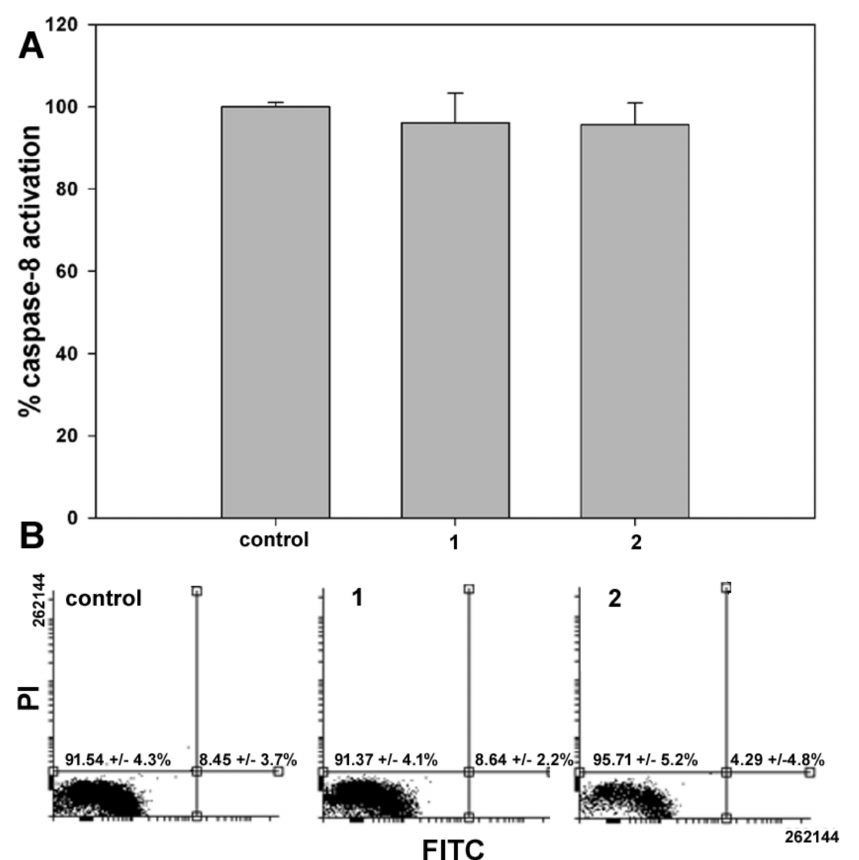
Figure 4. Representative flow cytometric assays for apoptosis in MDA-MB-231 cells cultured in control conditions or exposed to either 1 or 2 for 24 h. Evaluations of the extent of ( A ) caspase-8 activation using the Vybrant®FAM Caspase-8 Assay Kit, and ( B ) phosphatidylserine externalization using the Annexin V apoptosis Detection Kit. In ( B ), the dot plots show the result of a representative experiment and the percentages indicated in the left and right quadrants refer to live annexin V-/propidium iodide cells and early apoptotic annexin V+/propidium iodide cells, respectively. The results are expressed as the mean ± SEM of triplicate assays.